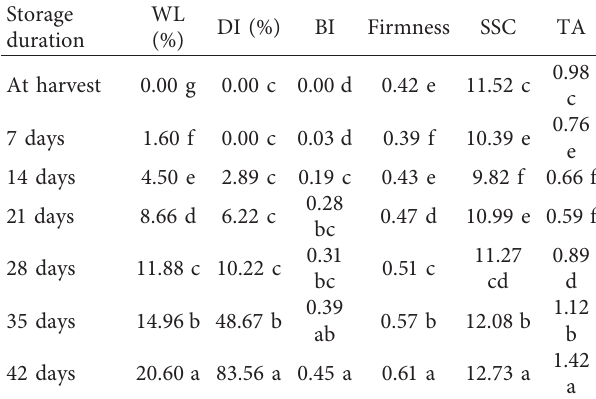
Table 3: Effects of cold storage on the different quality attributes (average of five different treatments) of loquat fruits during 42 days of storage.